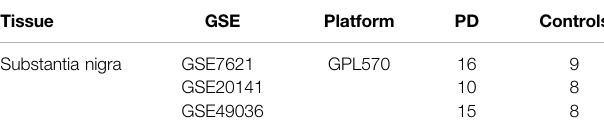
TABLE 1 | The number of samples for PD and controls in included datasets.